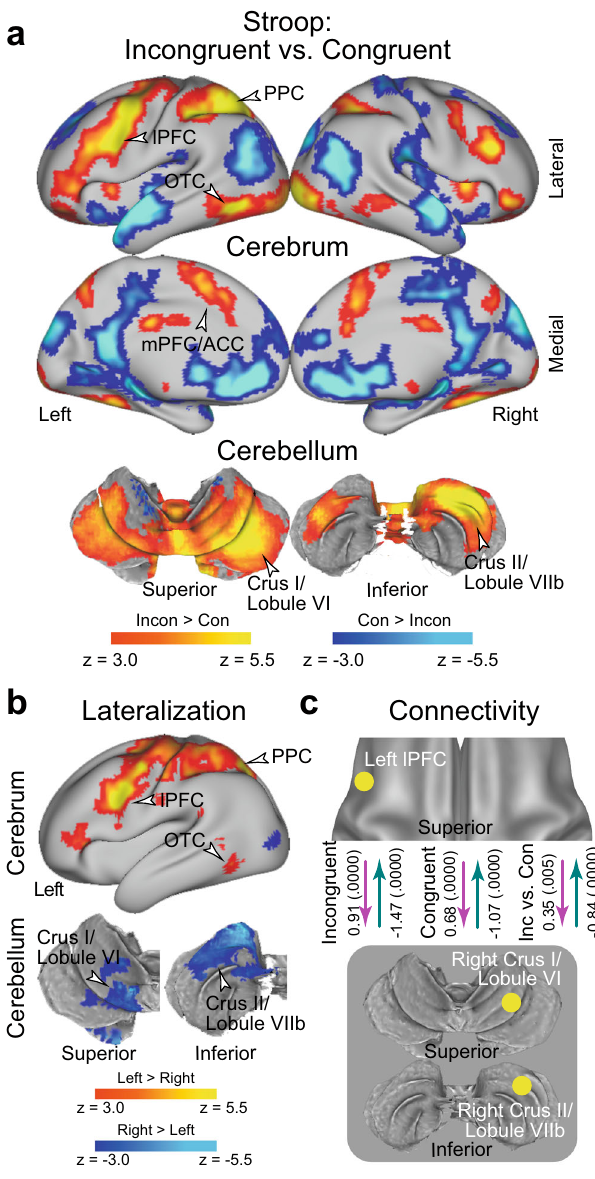
Fig. 3 | The Stroop effect involves a lateralized fronto-cerebellar loop during stimulus perception. a Statistical activation maps for signal increase and decrease in the contrast between incongruent and congruent trials in the Stroop task ( P <0.05, FWE-corrected across the whole-brain based on non- parametric permutation tests). The vocal and manual conditions were collapsed. Maps are overlaid onto a 3D surface of the brain. Hot and cool colors indicate signal increase and decrease in the incongruent trials, respec- tively. Arrowheads indicate anatomical locations of major activations. lPFC: lateral prefrontal cortex; PPC: posterior parietal cortex; OTC: occipitotemporal cortex; mPFC: medial prefrontal cortex; ACC: anterior cingulate cortex. b Statistical maps of brain regions showing differential Stroop effect activation ( a ) between the left and right hemispheres. Hot and cool colors indicate greater activity in the left and right hemispheres, respectively. c Task-related effective connectivity analysis between lPFC and cerebellar regions based on dynamic causal modeling. The values indicate estimates of the connectivity and their p-values calculated based on posterior probability density (one-tailed, uncor- rected)areshowninparenthesesnext.Thearrowdirectionsindicatetask-related effective connectivity. The magenta and green arrows indicate positive and negative effects,